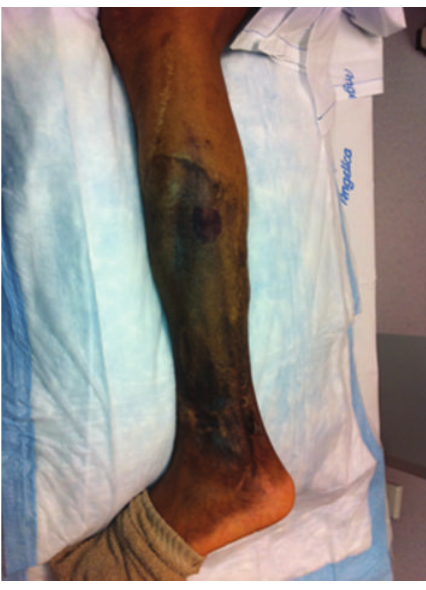
Figure 1: The blue skin marker demarcates the area of maximum pain in the hyperpigmented skin graft site of the left lower extrem- ity.